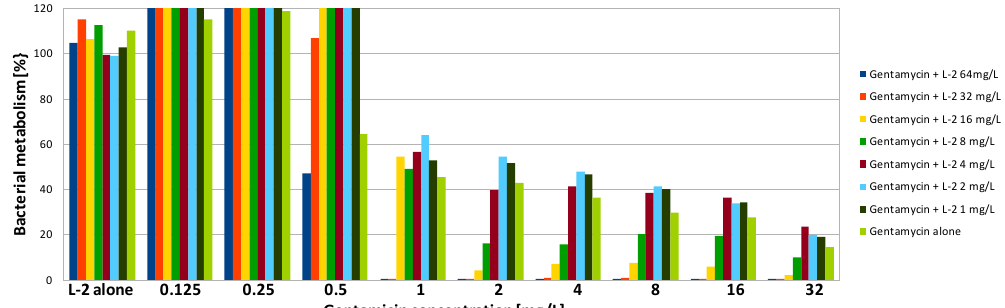
Figure 2. Activity of gentamicin in combination with lipopeptide 2 (L-2) against SA biofilm. Results presented as percentage of metabolic activity in comparison to positive (100%) and negative (0%) controls; RSD ≤ 20%.